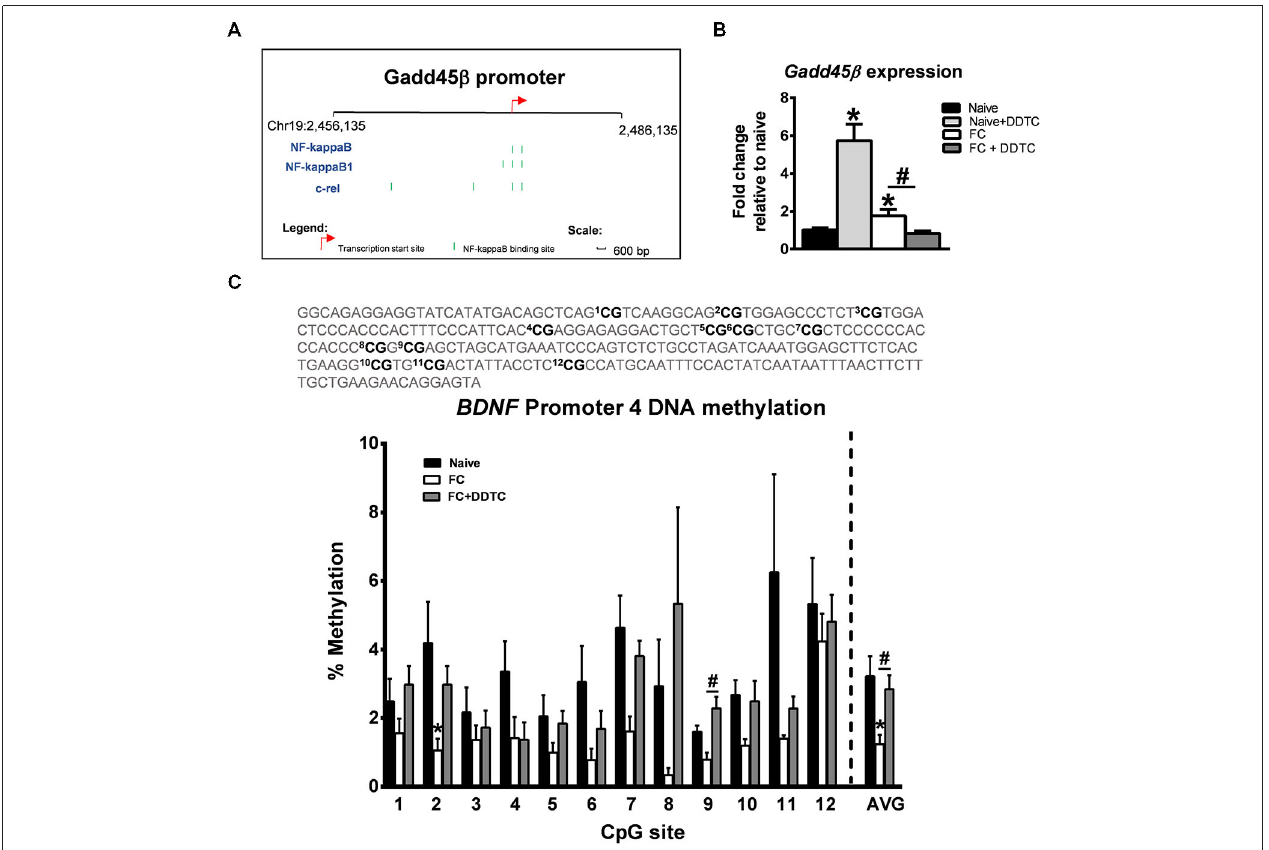
FIGURE 2 | Inhibition of NF- κ B activity abolishes learning-induced changes in Gadd45 β expression and BDNF DNA demethylation in the hippocampus. (A) In silico analysis revealed several NF- κ B consensus sequences in the Gadd45 β promoter. (B) Pharmacological inhibition of NF- κ B activity with DDTC abolished fear conditioning-induced increases in Gadd45 β expression in area CA1 ( n = 3–6 per group). (C) Bisulfite sequencing analysis of CpG sites in the rat BDNF Promoter 4 region revealed that inhibition of NF- κ B with DDTC completely prevented the fear conditioning-induced decreases in BDNF Promoter 4 DNA methylation in area CA1 ( n = 4–6 per group). ∗ p < 0.05 from Naïve. # p < 0.05 from